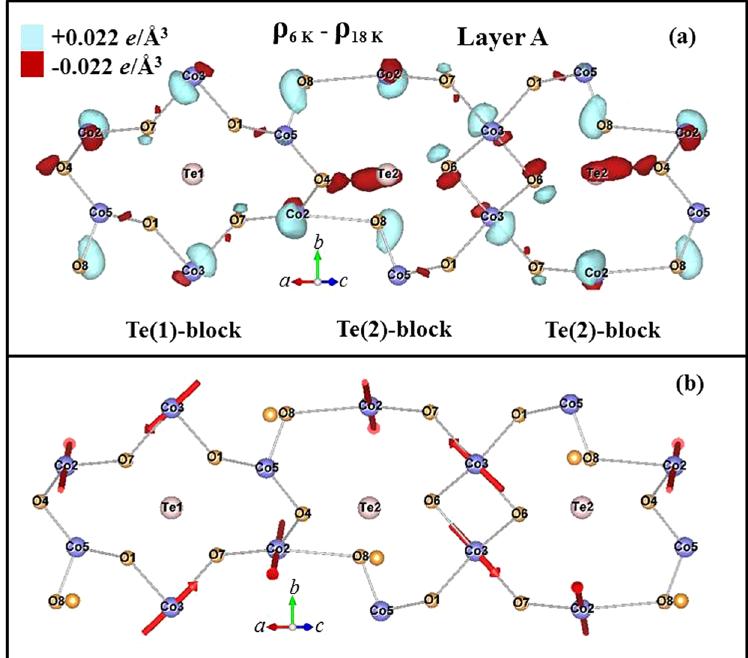
Figure 12. ( a ) Contour map of the electronic charge density in Layer A that develops upon cooling from 18 K to 6 K, as obtained from the x-ray diffraction data. The regions marked by contours for a difference ECD of + 0.022 e /Å 3 are marked by light (turquoise) shading, while those of − 0.022 e /Å 3 are marked in dark (red) shading. ( b ) Arrows are used to indicate the electric dipoles that are associated with the difference electronic charge density on the ions, revealing an antiferroelectric-type of structure.